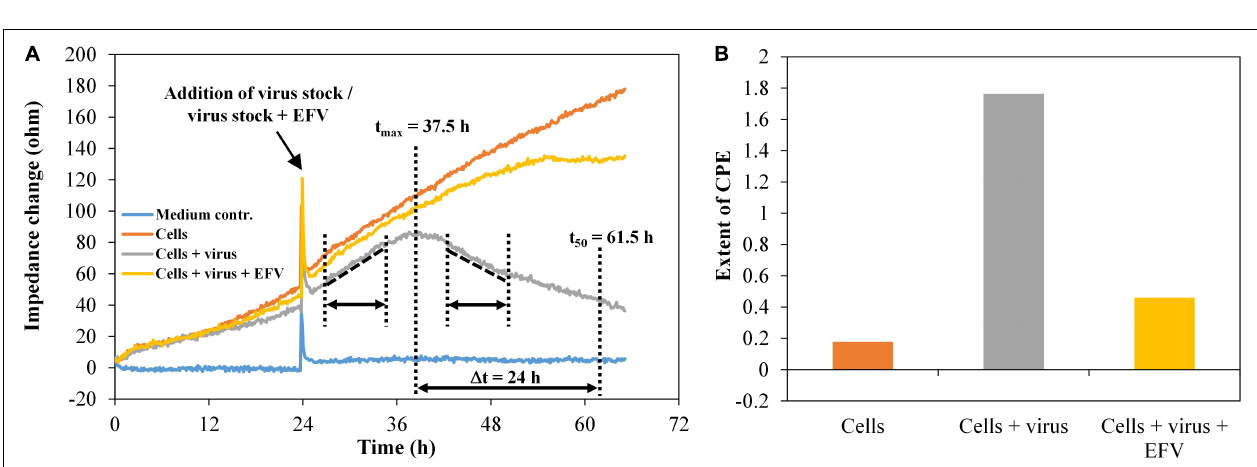
FIGURE 6 | TZM-bl cells, exposed to different virus concentrations, n = 2. (A) Impedance curves. All curves were set to 0 (cid:127) at t = 0. The slope of the medium average was corrected to zero, and all other curves were modified correspondingly. The dashed and dotted lines in the diagram illustrate the curve regions used to calculate the extent of the cytopathic effect (CPE). (B) Extent of CPE as a function of virus concentration. Values were calculated, using the time intervals illustrated in (A) and the formula described in section “Fabrication of Graphene-Based Biosensors.”